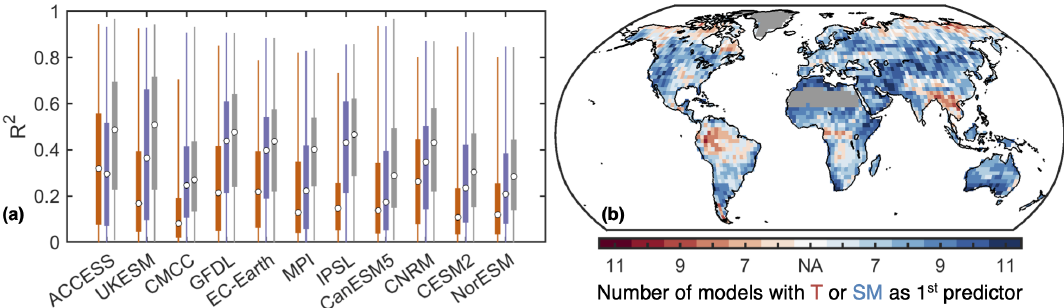
Figure 4. Temperature and soil moisture as drivers of the detrended interannual variability of NBP. (a) Area-weighted distribution from all grid cells of the coefficient of determination ( R 2 ) between NBP with T (orange), SM (purple), and both T and SM from a stepwise linear regression (gray). The circle indicates the median, the boxes span the interquartile range, and the whiskers the full range. (b) Model agreement at each location where either T or SM is added first to the stepwise linear regression. Regions with 2015–2100 average GPP below 100gCm 2 yr − 1 are omitted in panel (a) and masked in panel (b)